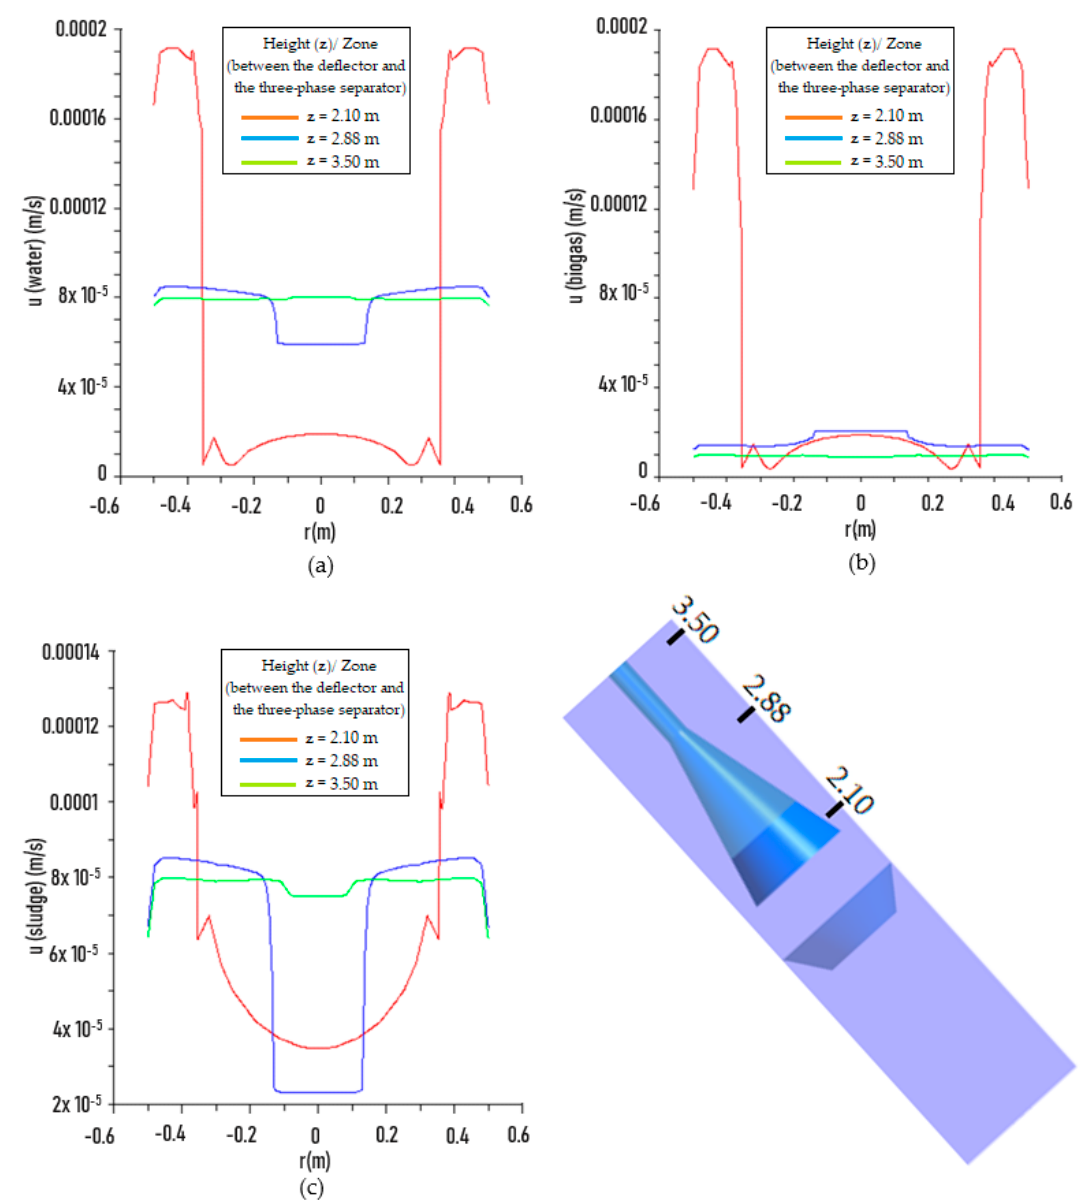
Figure 17. Distribution of the resulting velocity according to the radial position for different axial positions, z, on the three-phase separating region (downward inclination of the deflector): ( a ) water, ( b ) biogas, and ( c ) sludge.